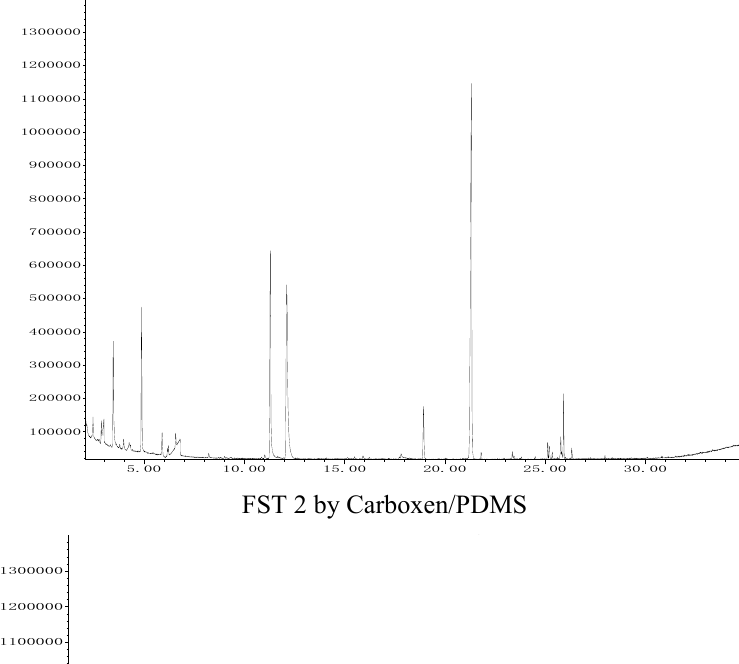
Figure 2. The total ion chromatograms of organic flavor compounds in FST 2 extracted with the four SPME fibers corresponding to Table